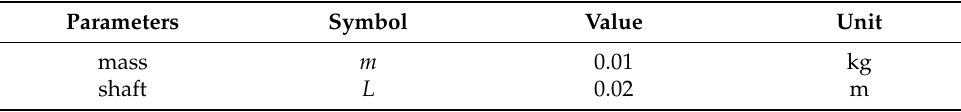
Table 1. Parameters of the simulated underactuated